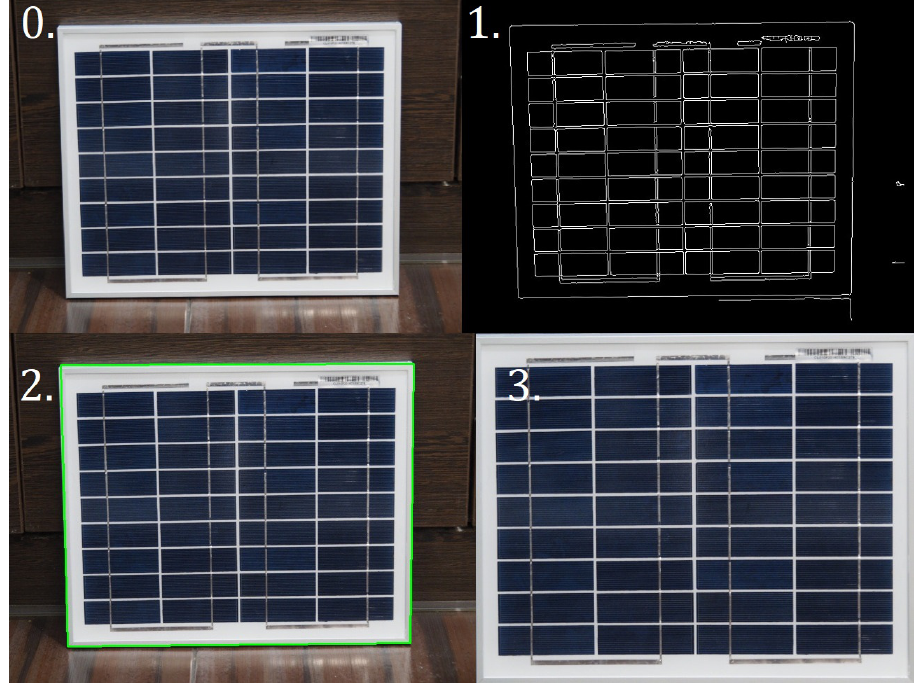
Figure 5. Successive stages of extracting the PV panel from the photo. 0—starting image; 1—detected edges in the picture; 2—outer edges of the PV panel found; 3—the result of the perspective transfor-